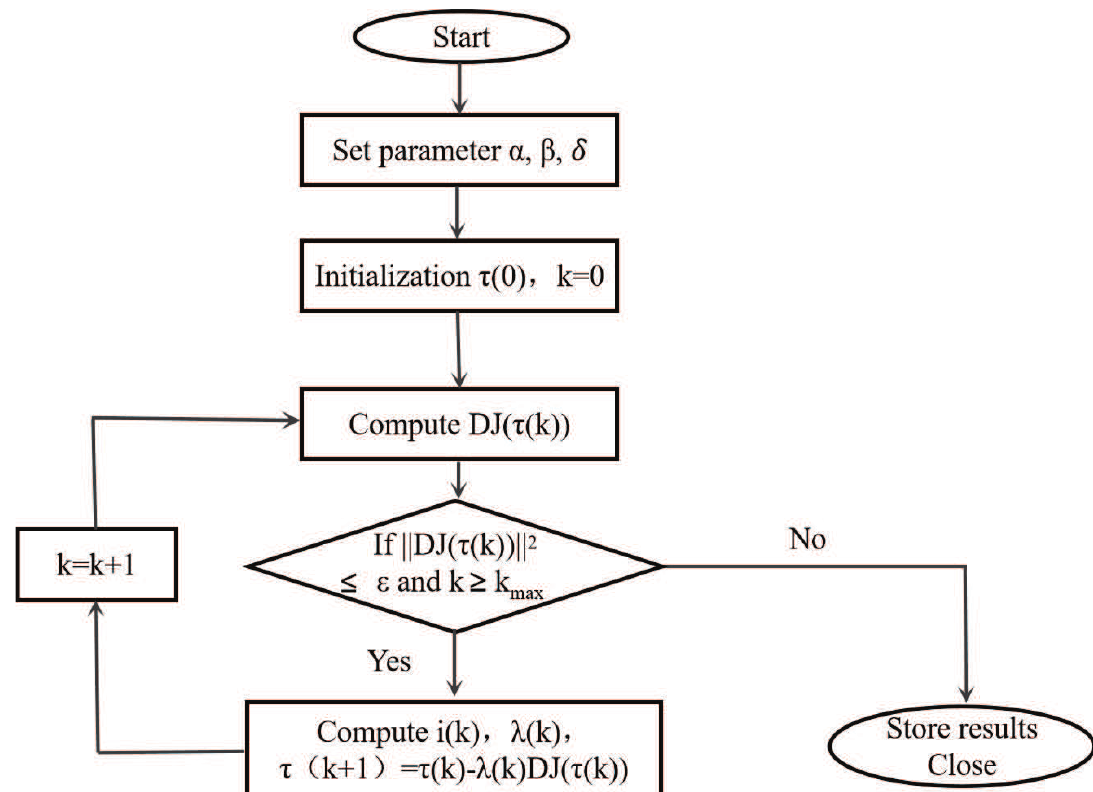
Figure 2. The steepest descent algorithm flow